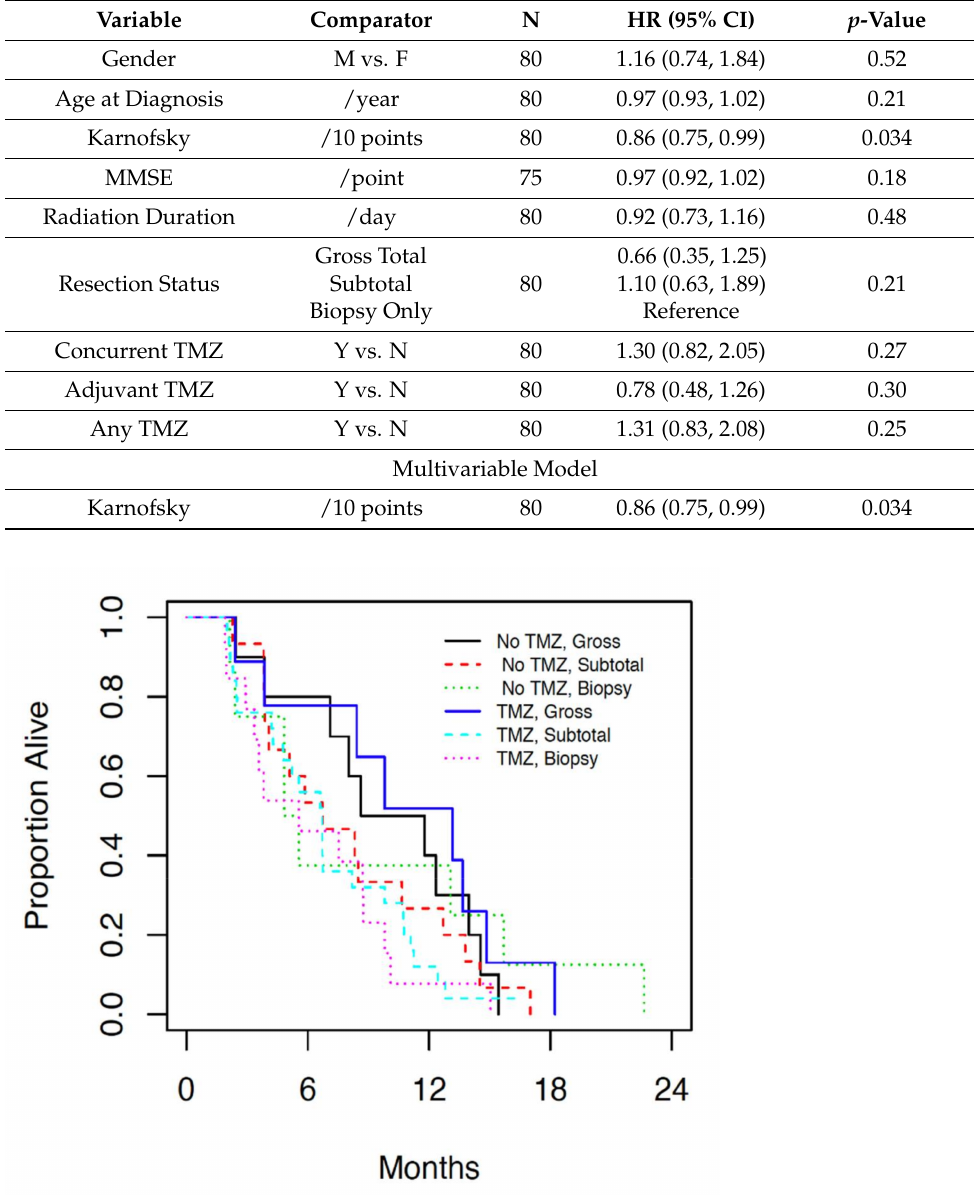
Table 2. Results of the univariable and multivariable Cox regression analyses.